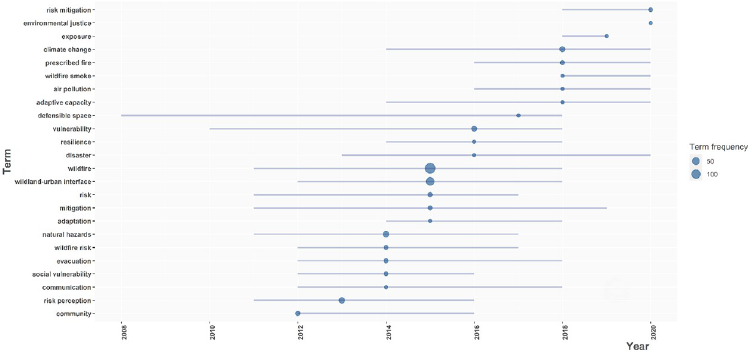
Fig 5. Temporal trends in topics and the frequency of the use of that author keyword in the socio-demographic dimensions and wildfire literature.